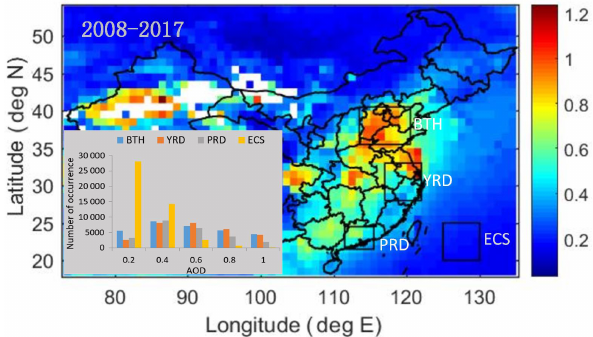
Figure 1. Map of MODIS/AQUA level 3 AOD over eastern China averaged over the period from 2008 to 2017. The location of the four clusters (three urban and one ocean) studied here (Beijing–Tianjin– Hebei: BTH, Yangtze River Delta: YRD, Pearl River Delta: PRD and East China Sea: ECS) are marked with black rectangles. The inset shows a histogram for the occurrence of AOD values in each of the four clusters during the period